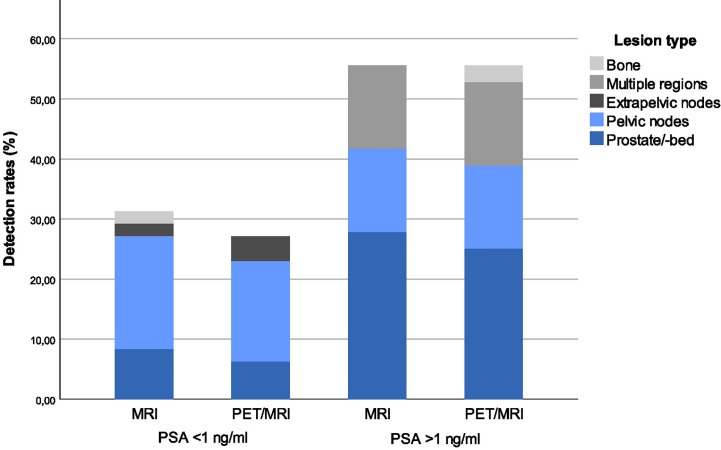
Patient-based detection rates stratified by PSA-level and lesion site. When lesion site is “multiple regions” this indicates patients with lesions in multiple regions (according to the main regions used in Table 2).